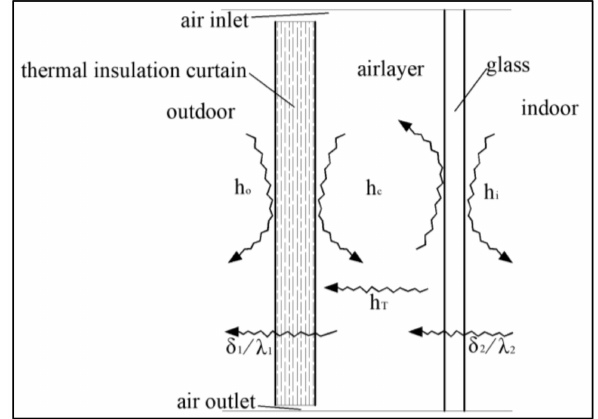
Figure 3. Calculation diagram of heat transfer